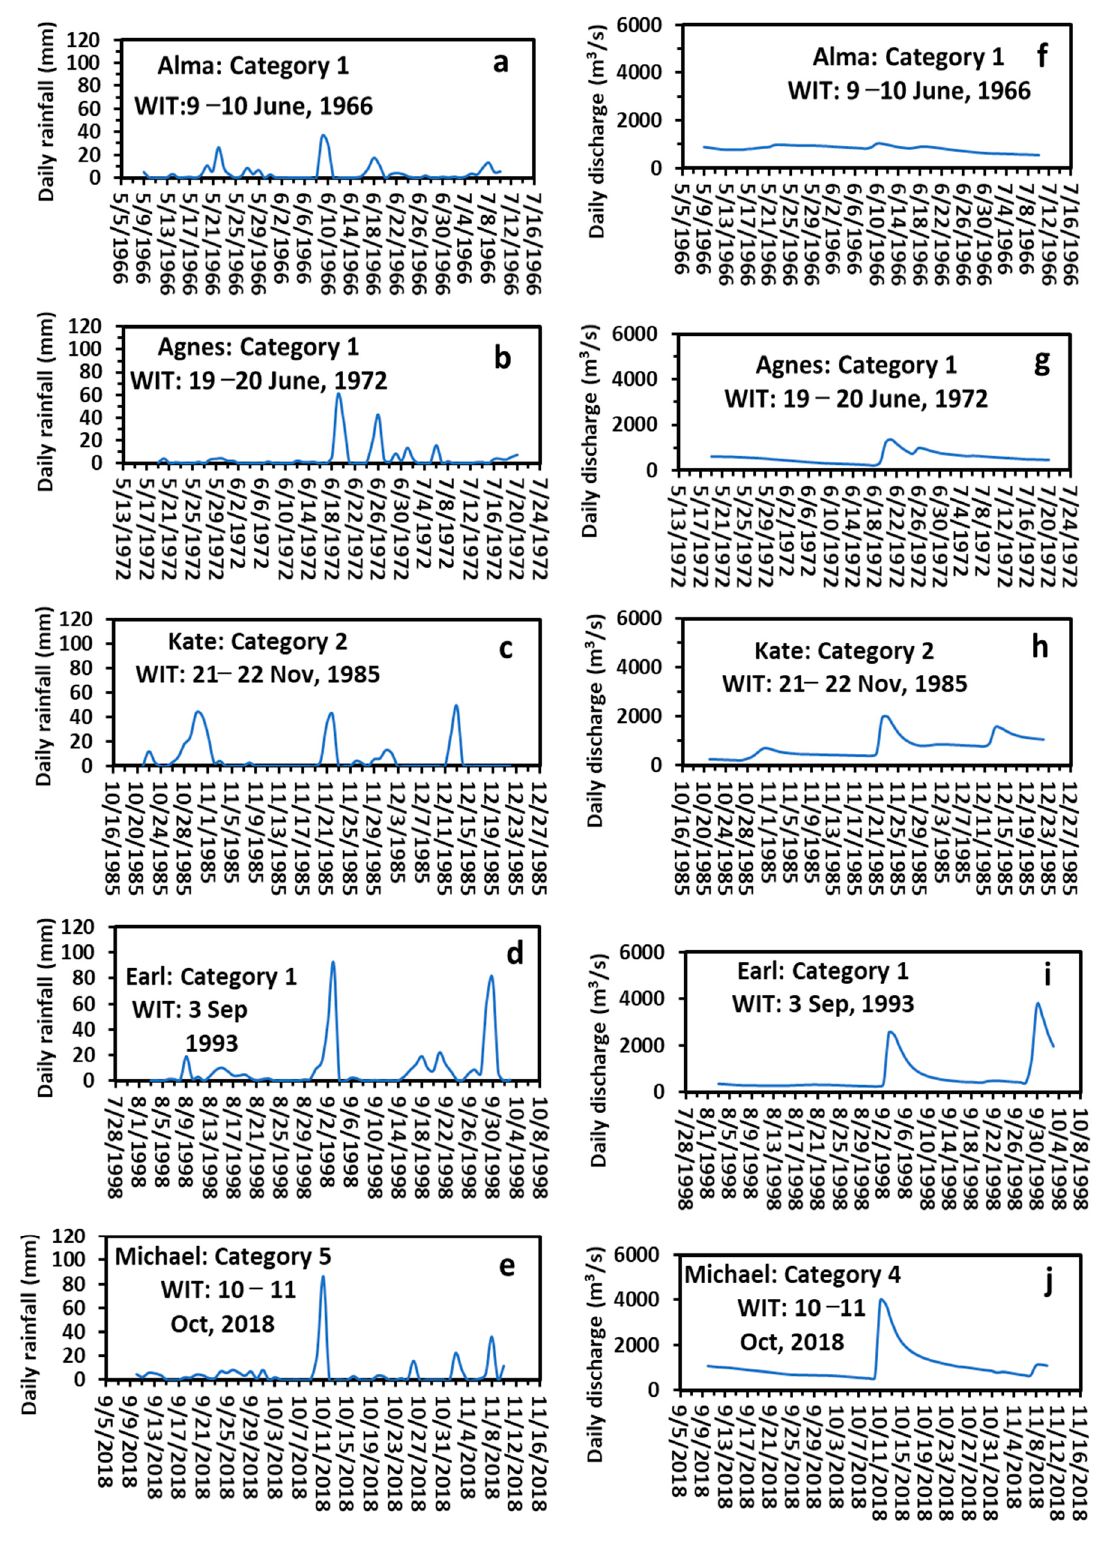
Figure 3. Daily rainfall and stream discharge under five hurricanes from 1966 to 2018. WIT is the watershed impact times.